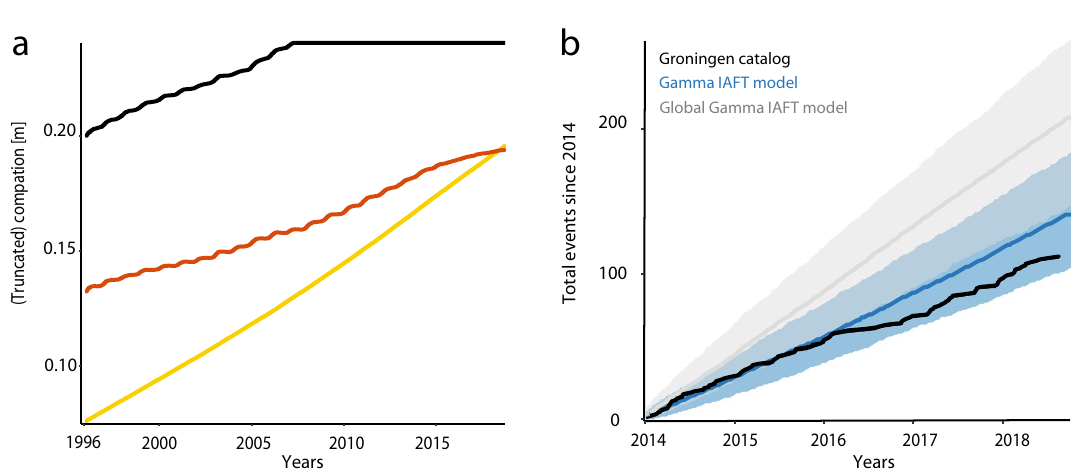
Figure 2. Results from the Gamma IAFT model for the Groningen case. ( a ) The evolution of the truncated total compaction (m) in the most active region (Loppersum, black, indicating critical stress from the end of 2007) compared to the compaction in the two regions highlighted in Fig. 1c. ( b ) Groningen catalog during the period 2014–2018 (black) and the median of thousand predicted catalogs using the (local) Gamma IAFT model (blue), respectively the global Gamma IAFT model that ignores spatial heterogeneity (grey). The 2.5% and 97.5% point- wise quantiles are presented as shaded areas (fit details in Supplemental text S3.3). Note that, after an offset in the first half of 2016, the real event rate still closely equals the median model prediction.